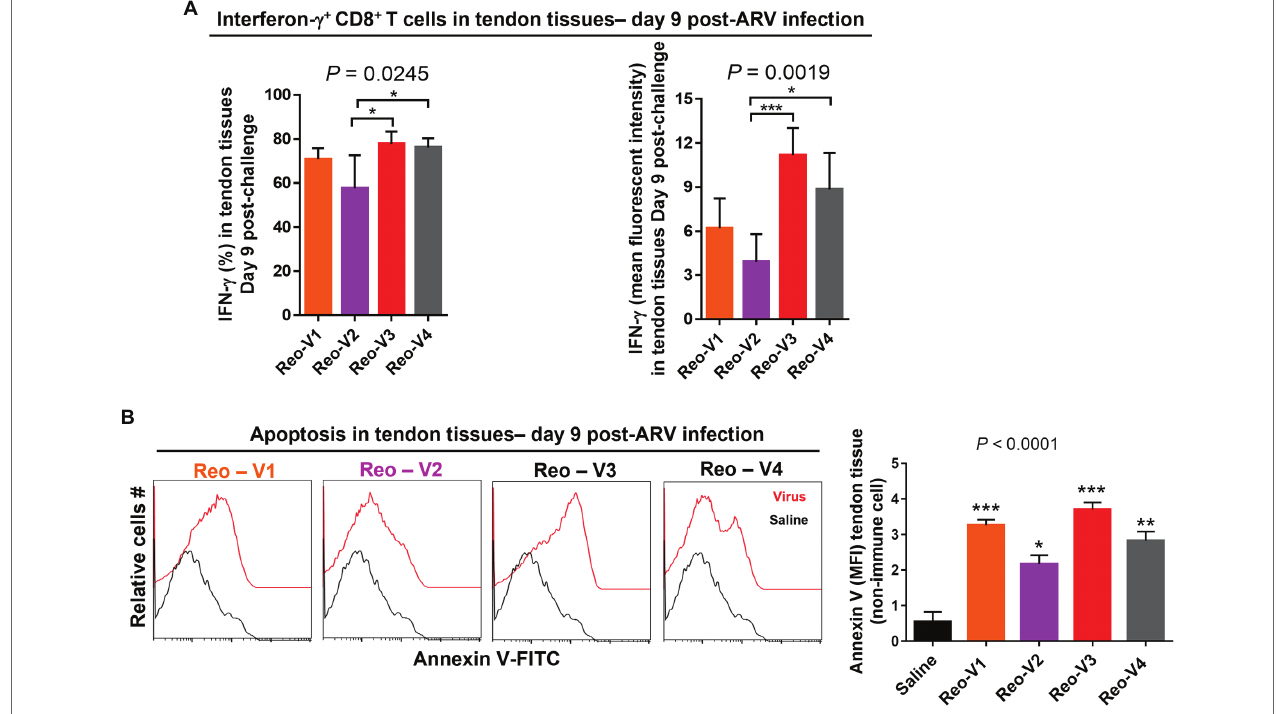
FIGURE 8 | Flow cytometry analysis of the cytotoxic activity of the tendon infiltrating CD8+ T lymphocytes in birds infected with different ARVs [i.e., Reo-V1 (Cluster-5), Reo-V2 (Cluster-4), Reo-V3 (Cluster-2), or Reo-V4 (Cluster-6)]. (A) Percentage and mean fluorescent intensity (MFI) of interferon (IFN)- γ producing CD8+ T lymphocytes in the tendon tissues of ARV infected birds at day 9 post-infection based on three separate experiments. Columns: mean ± SD. (B) Apoptosis of cells of tendon tissues of ARV infected birds at day 9 post-ARV infection. Bar graph: MFI of apoptotic tendon tissue cells at day 9 post-infection based on three separate experiments. Asterisks indicate groups that were significantly different from the control group, * p < 0.05, ** p < 0.001, and *** p <